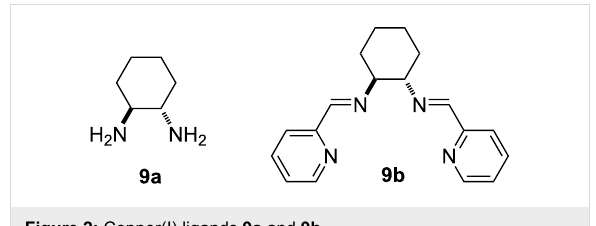
Figure 2: Copper(I) ligands 9a and 9b